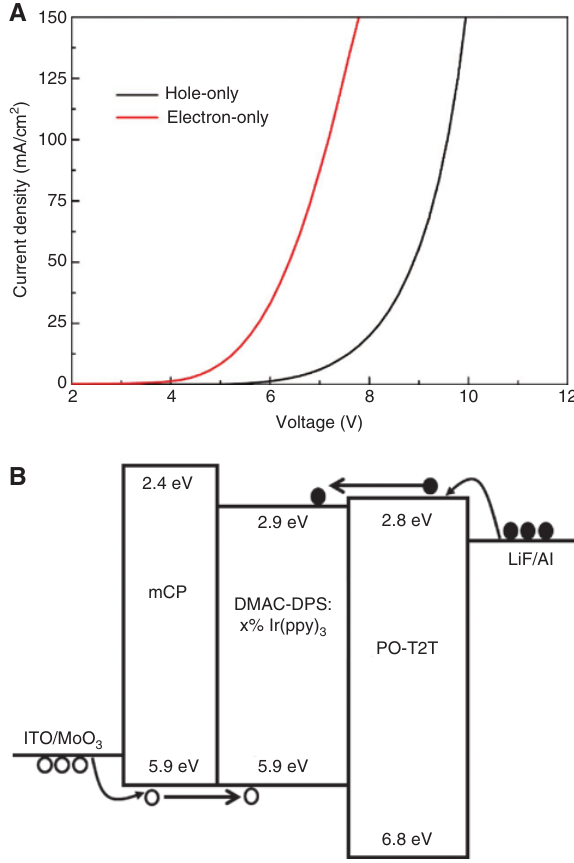
Figure 5: (A) The current density-voltage curves of single carrier devices. (B) The energy level schematic diagram of